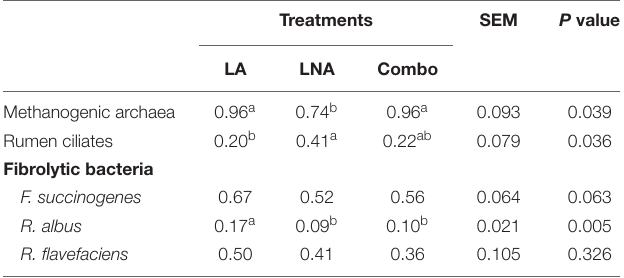
TABLE 4 | Effects of fatty acid supplementation on microbial populations of rumen buffer after 8 h of incubation (fold change unit). Treatments SEM P value LA LNA Combo Methanogenic